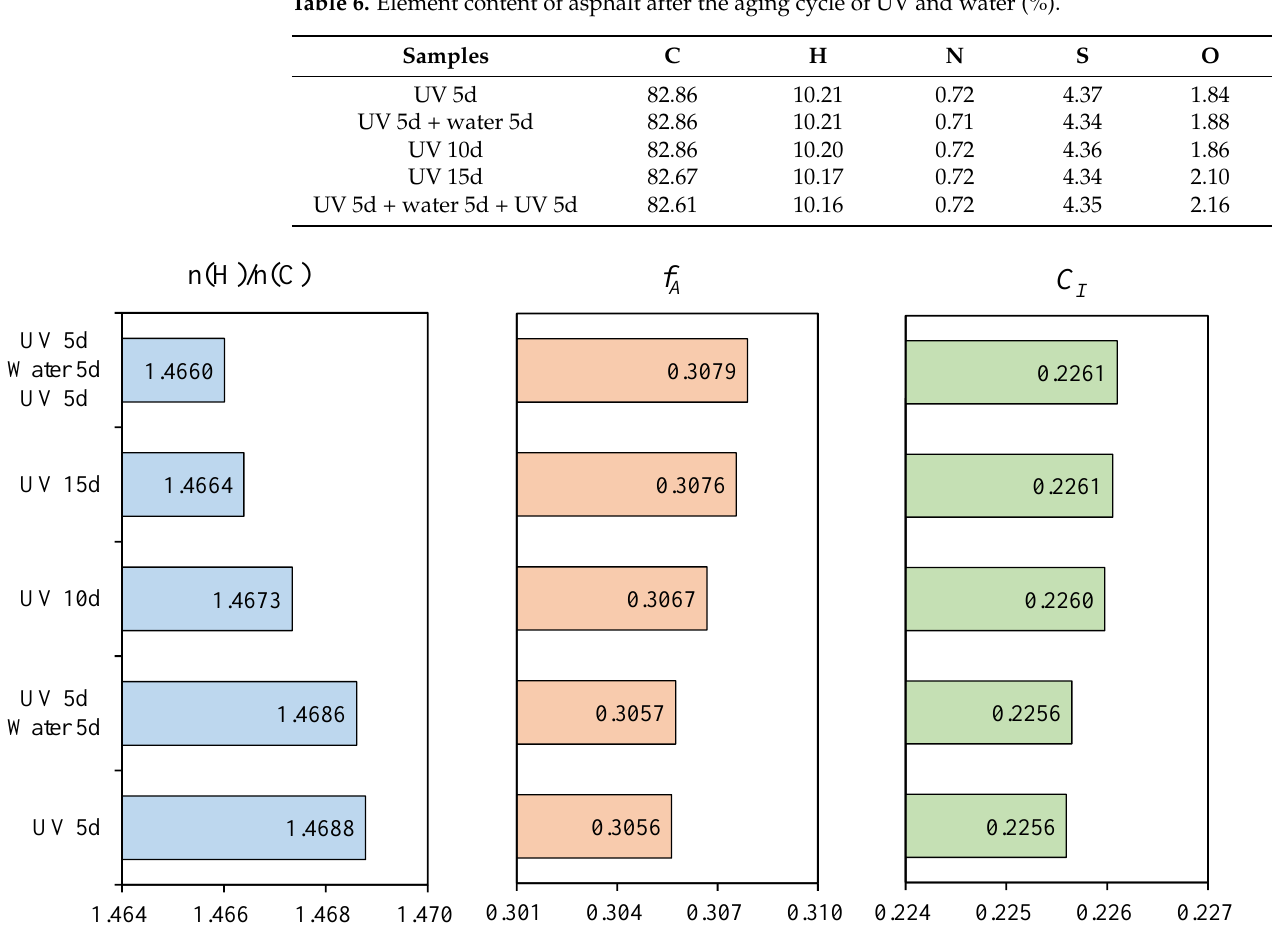
Figure 8. Important indexes (n(H)/n(C), f A and C I ) of asphalt after the aging cycle of UV and water.